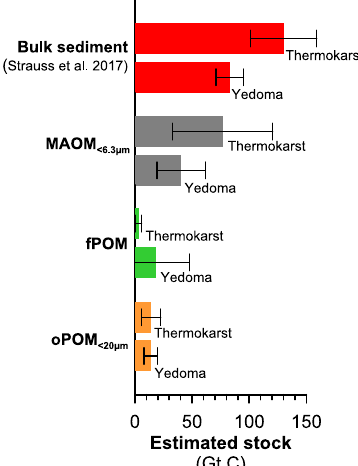
Fig. 4 | Estimated carbon stock in bulk sediments and organic matter (OM) fractions. The different organic carbon (OC) pools are mineral-associated OM (MAOM <6.3 µ m in gray), free particulate OM (fPOM in green) and occluded particu- late OM (oPOM <20 µ m in orange) in Yedoma deposits and thermokarst sediments. The OC pools and uncertainties (with the standard deviation shown as error bars) wereestimated based onpublishedOCstocks(and itsuncertaintyestimatesbased onobservationalOCvariability)inlatePleistocenepermafrost 2 (shownasredbars), which is further described in the